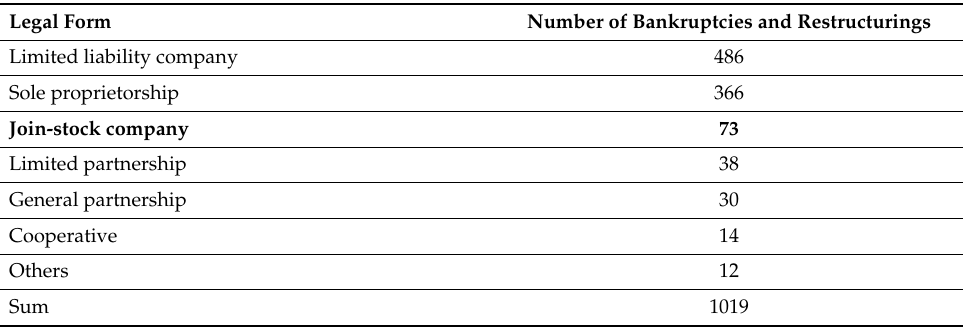
Table 2. Bankruptcies and restructurings in Poland by legal forms—the year